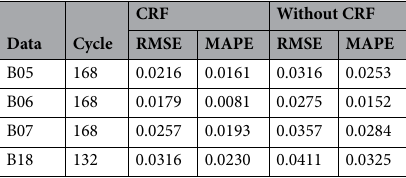
Table 5. CRF comparison experiment predicted the